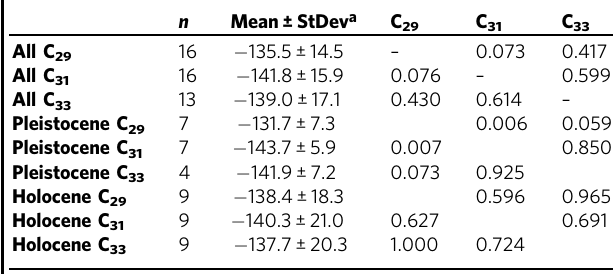
Table 3 Mann – Whitney U -test (bottom/left) and Kruskal- Wallis test (top/right) for n -alkane compound δ